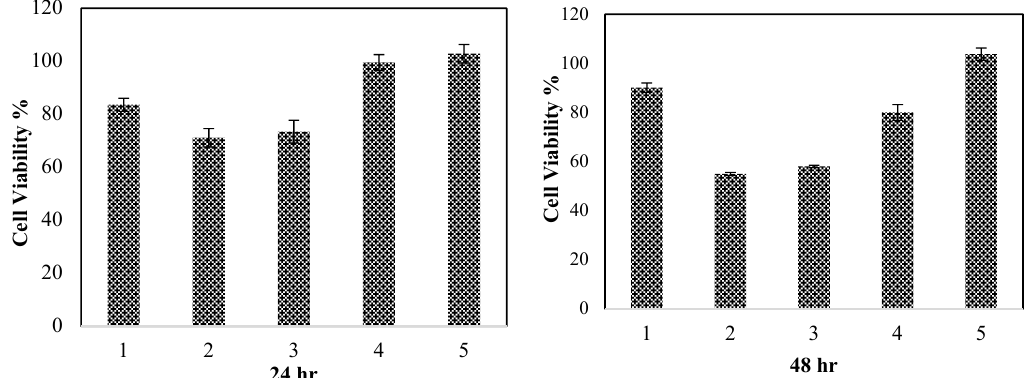
Figure 6. Cell viability of the PEC films: (1) TM-nanoemulsion, (2) PEC 1, (3) PEC 0.4, (4) TM-PEC %0.4, (5) TM-PEC %1.